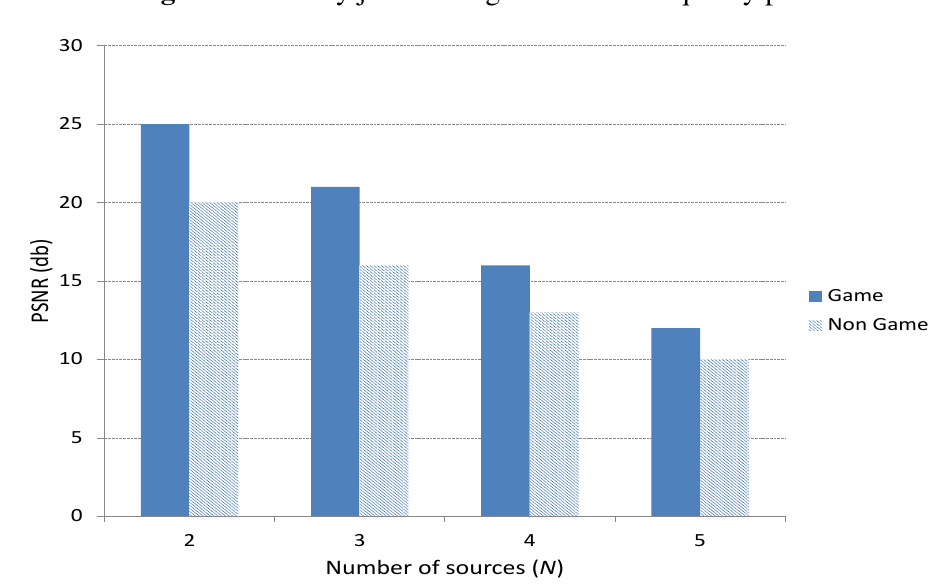
Figure 12. Delay jitter through the medium-quality path.